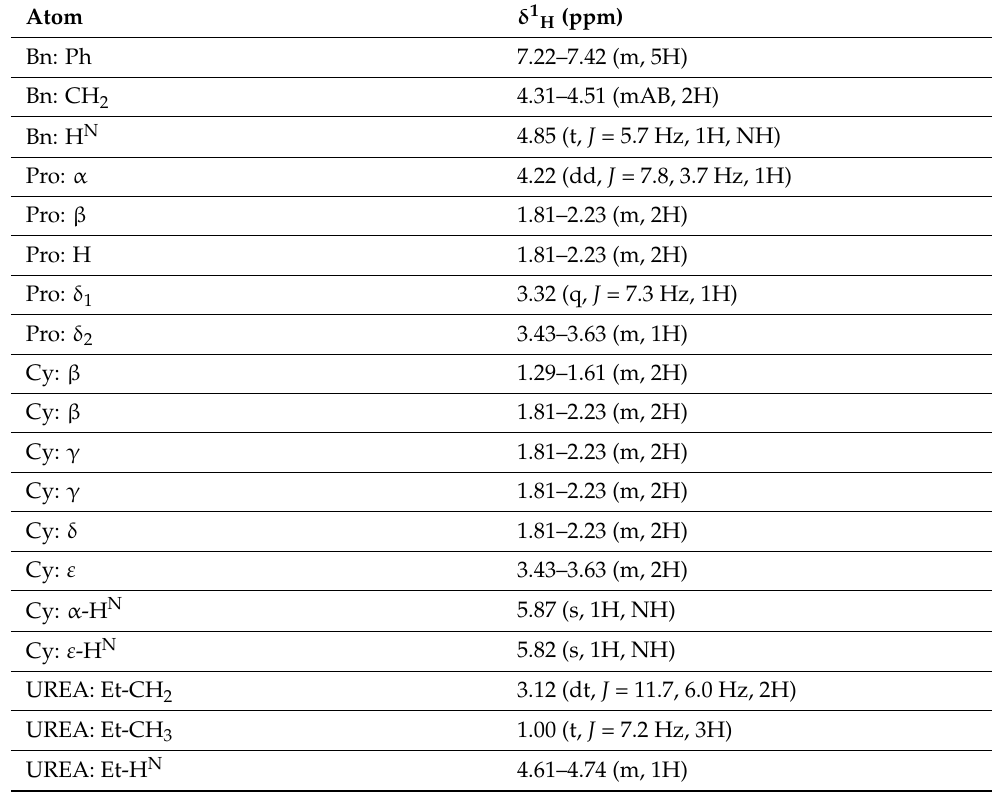
Figure 4. 1 H NMR spectrum of compound 3 at +25 °C (CDCl 3 , 500 MHz). Table 1. Assignment of the 1 H NMR signals of compound 3 (+25 °C, CDCl 3 , 500 MHz).